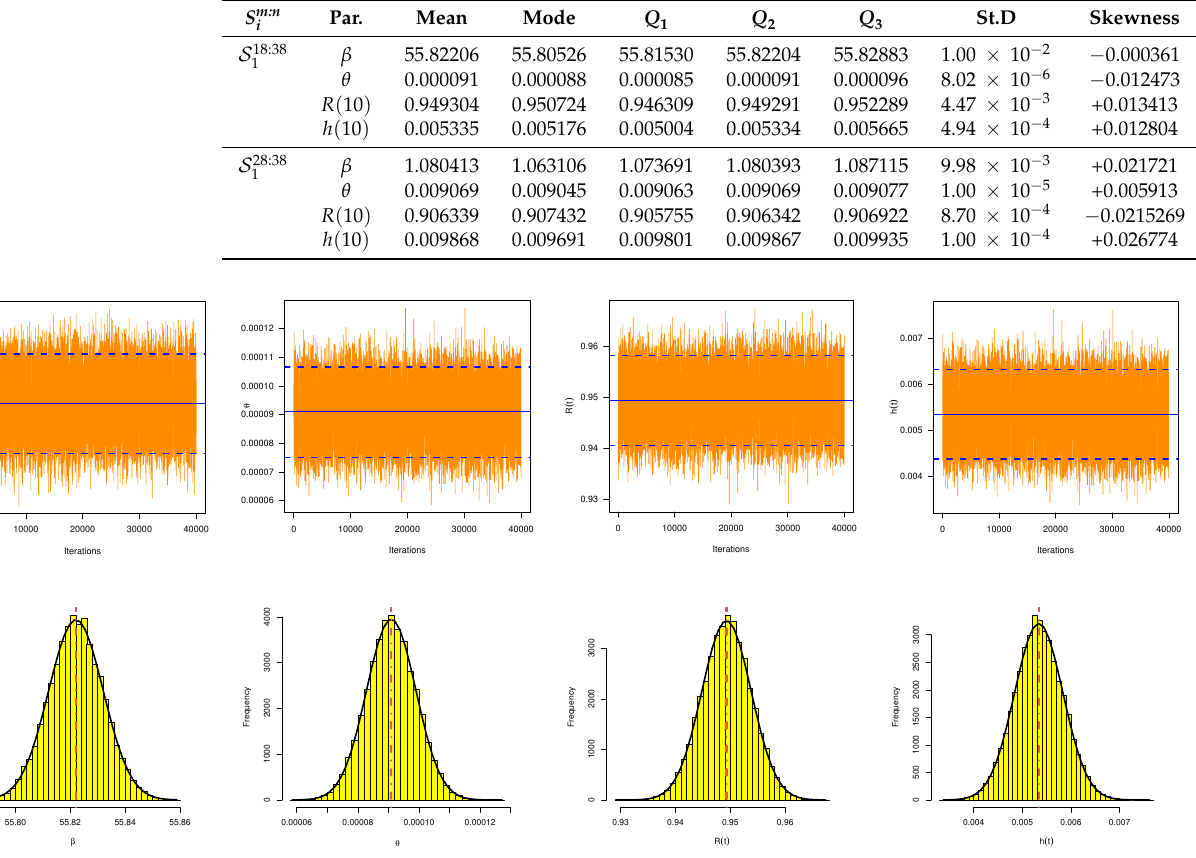
Figure 6. Trace ( top panel) and Histogram ( bottom panel) plots of β , θ , R ( t ) , and h ( t ) under MTS